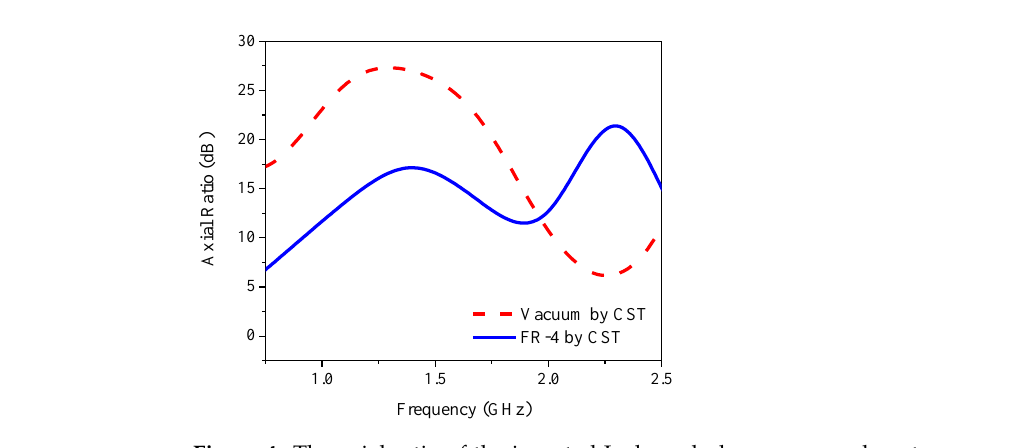
Figure 4. The axial ratio of the inverted L-shaped planar monopole antenna on a partial ground plane in vacuum and with FR-4 substrate.